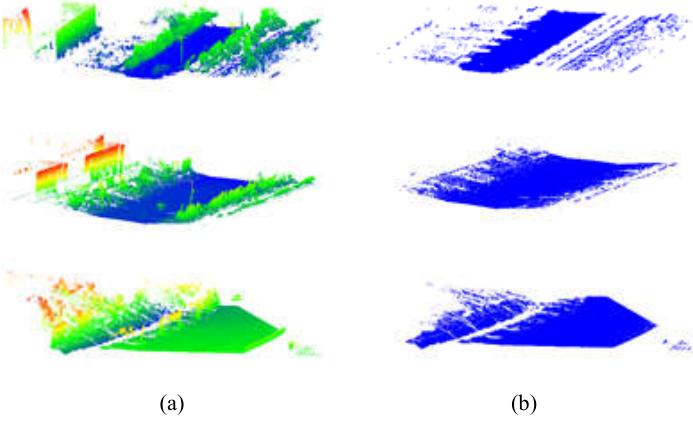
Figure 3.Results of each sample: (a) original datasets colored by height; (b) the ground points extracted from the CSF algorithm.